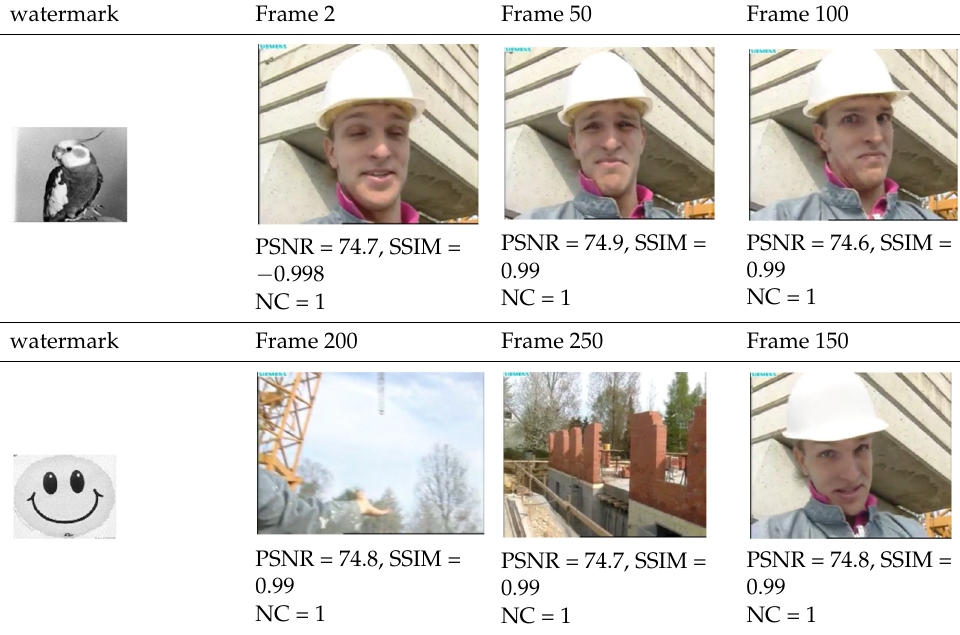
Table 4. Extracted watermark and NC value under various